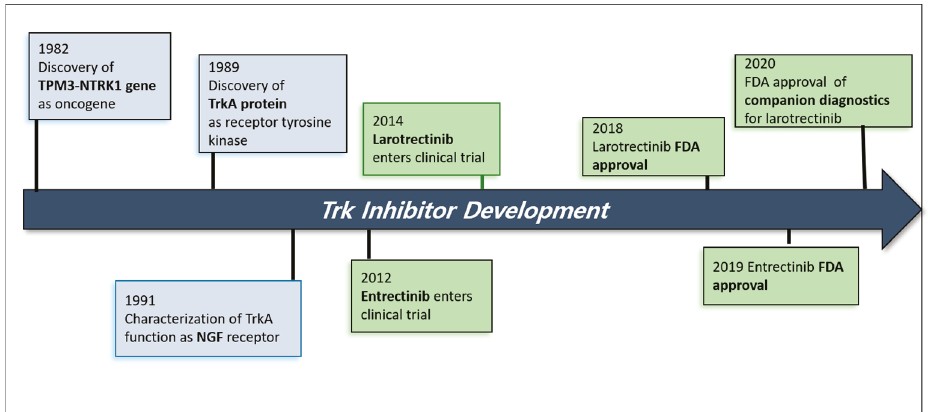
Figure 1. Timeline for the clinical development of larotrectinib and entrectinib. TPM3, tropomyosin 3; NTRK1, neurotrophic tyrosine receptor kinase 1; TrkA, tropomyosin receptor kinase A; NGF, nerve growth factor; FDA, US Food and Drug Administration.